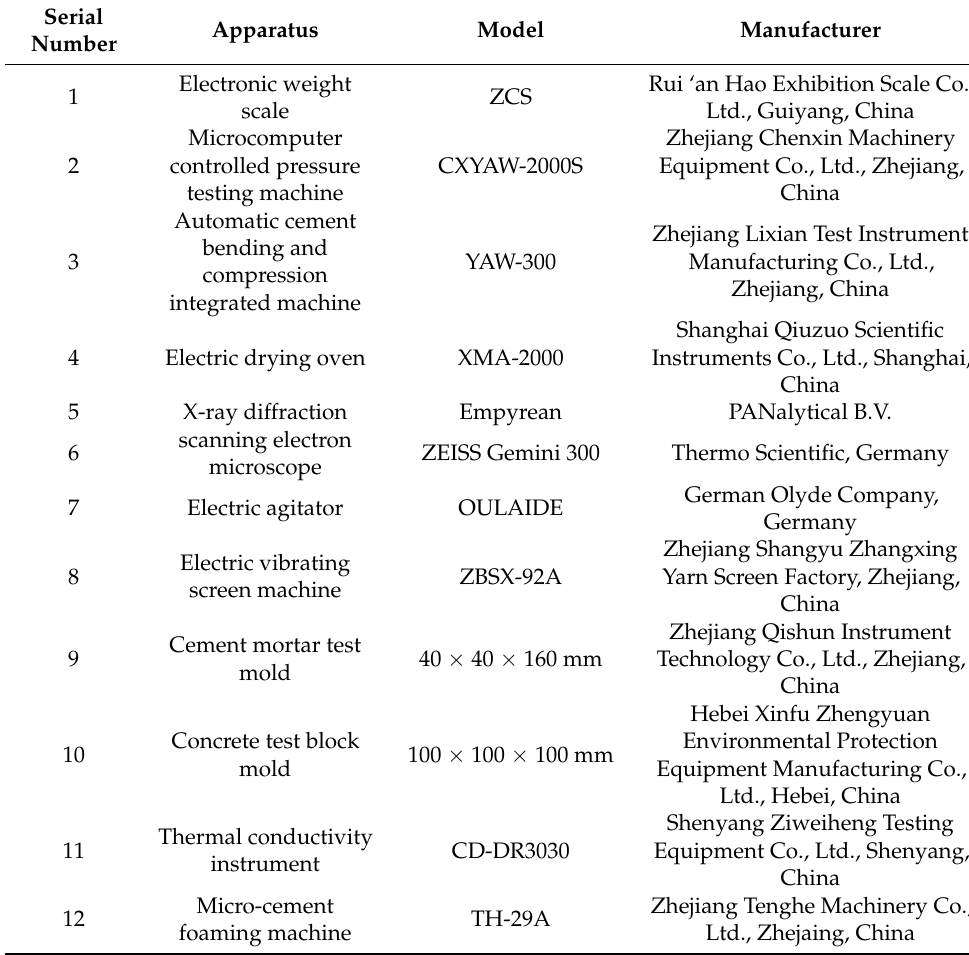
Table 3. The test